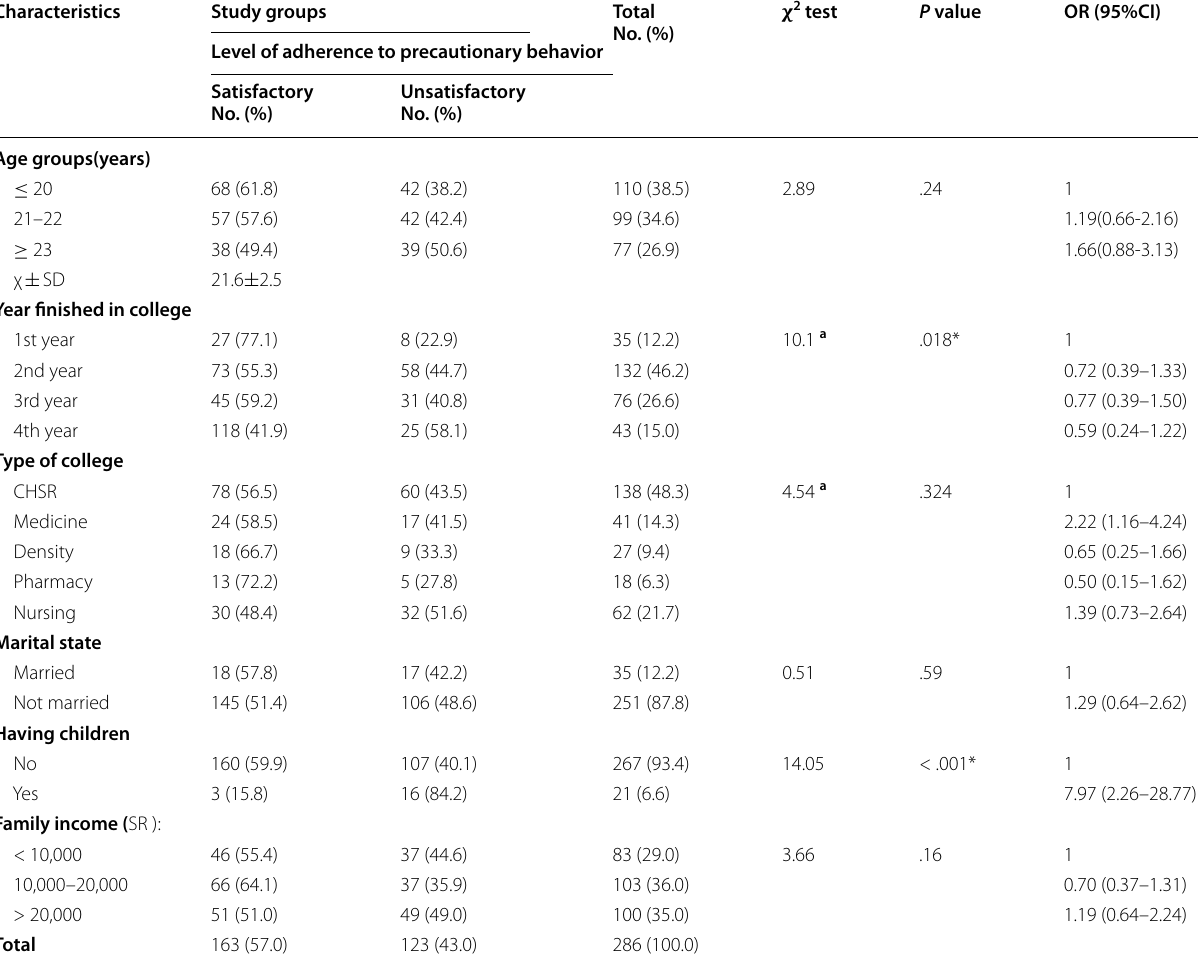
Table 2 Adherence to COVID-19 precautionary health behavior according to sociodemographic characteristics of the students